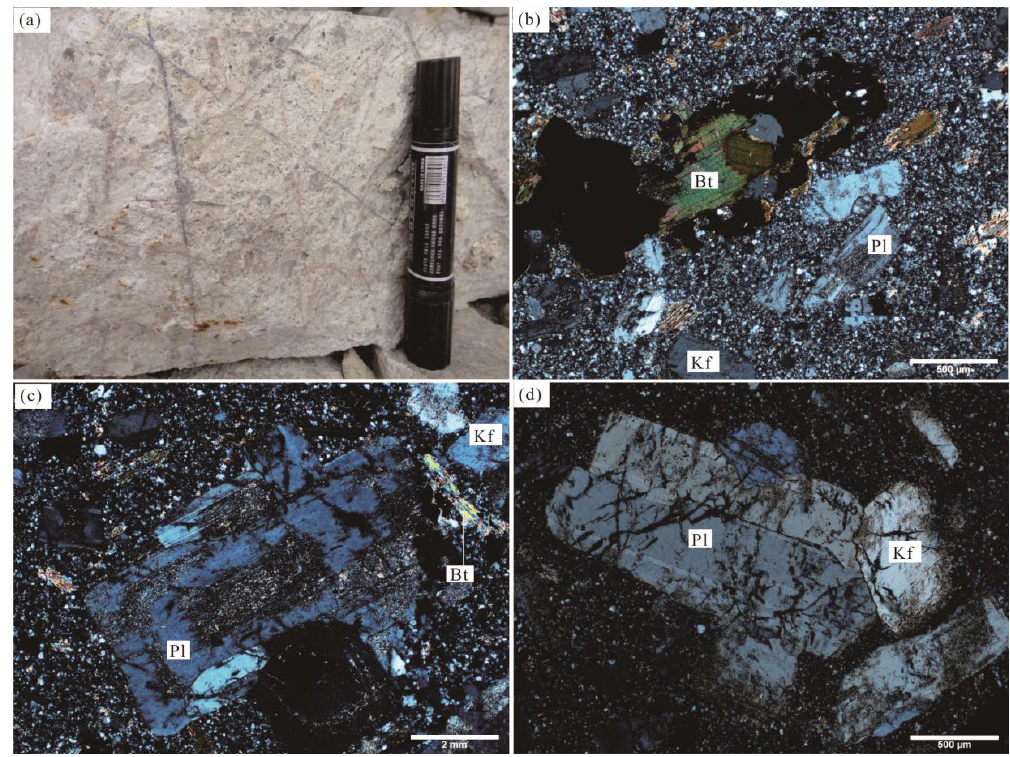
Figure 4. Hand specimens and photomicrographs showing petrology of Leimengou granite porphyry and monzonitic granite porphyry. Bt—biotite; Kf—feldspar;